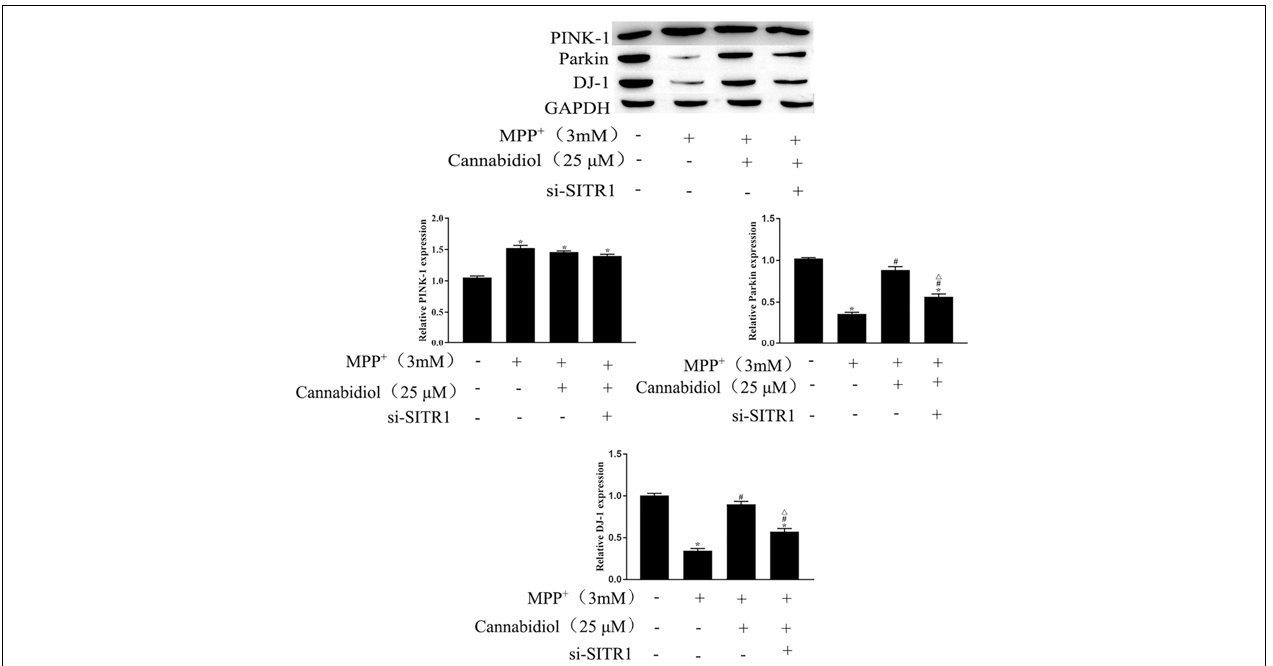
FIGURE 5 | Cannabidiol protected SH-SY5Y cells mitochondrial proteins through SIRT1. The expression of Parkin, PINK-1, DJ-1 in SH-SY5Y cells were measured by western blotting; * p < 0.05, compared with the control group, # p < 0.05 compared with MPP + alone, (cid:77) p < 0.05 compared with MPP + + Cannabidiol.